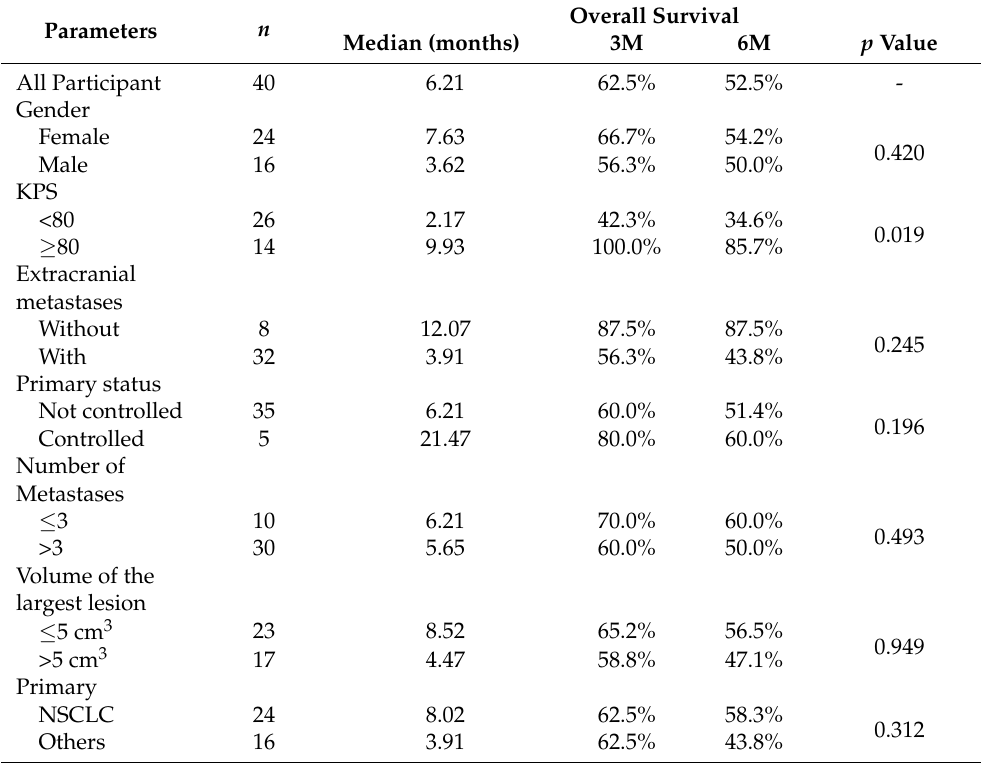
Table 3. Univariate analysis on overall